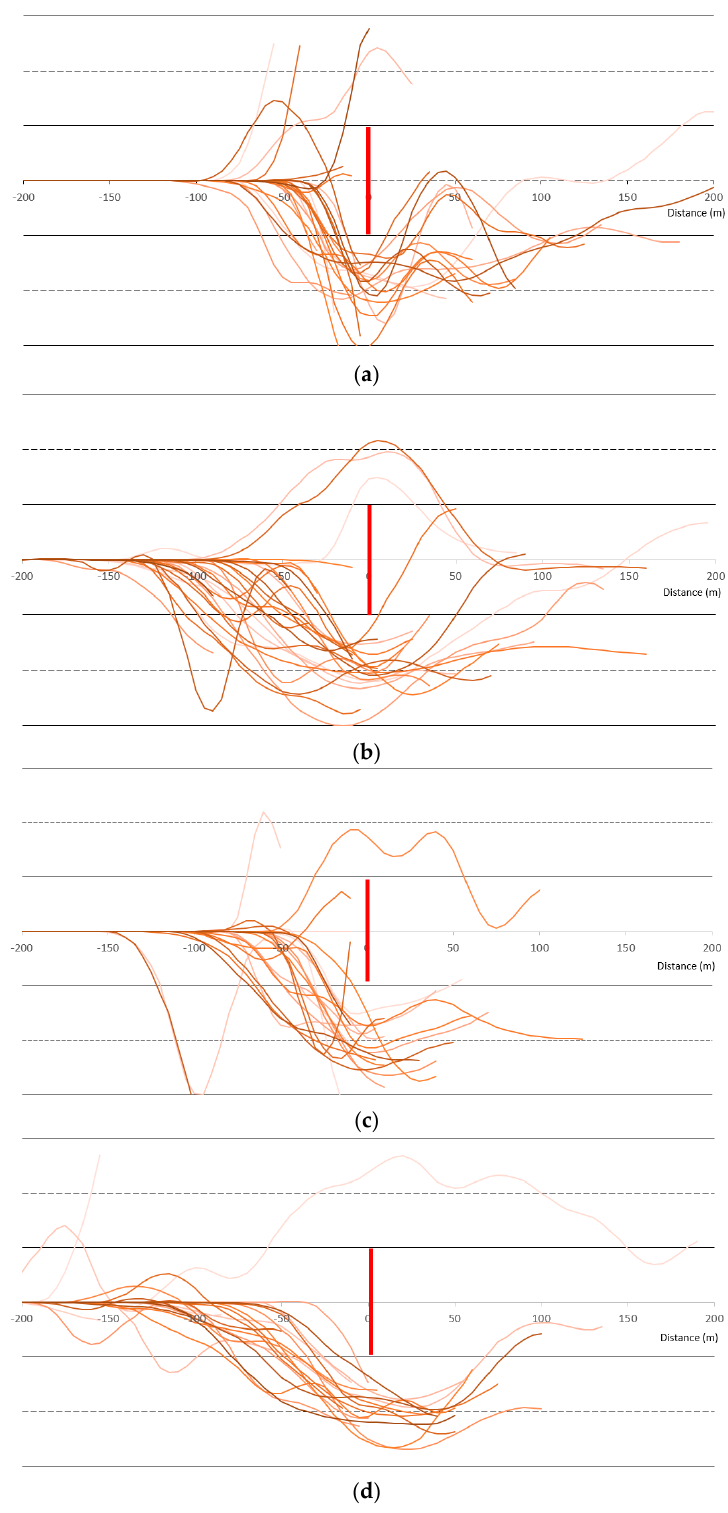
Figure 5. Trajectories from the four conditions, ( a ) front-facing low time budget; ( b ) front-facing high time budget; ( c ) rear-facing low time budget, and ( d ) rear-facing high time budget. The vertical red bar represents the location of the obstacle. Horizontal solid lines represent lane boundaries in the three-lane setup. Horizontal dash lines represent lane centres. The width of a lane was 4